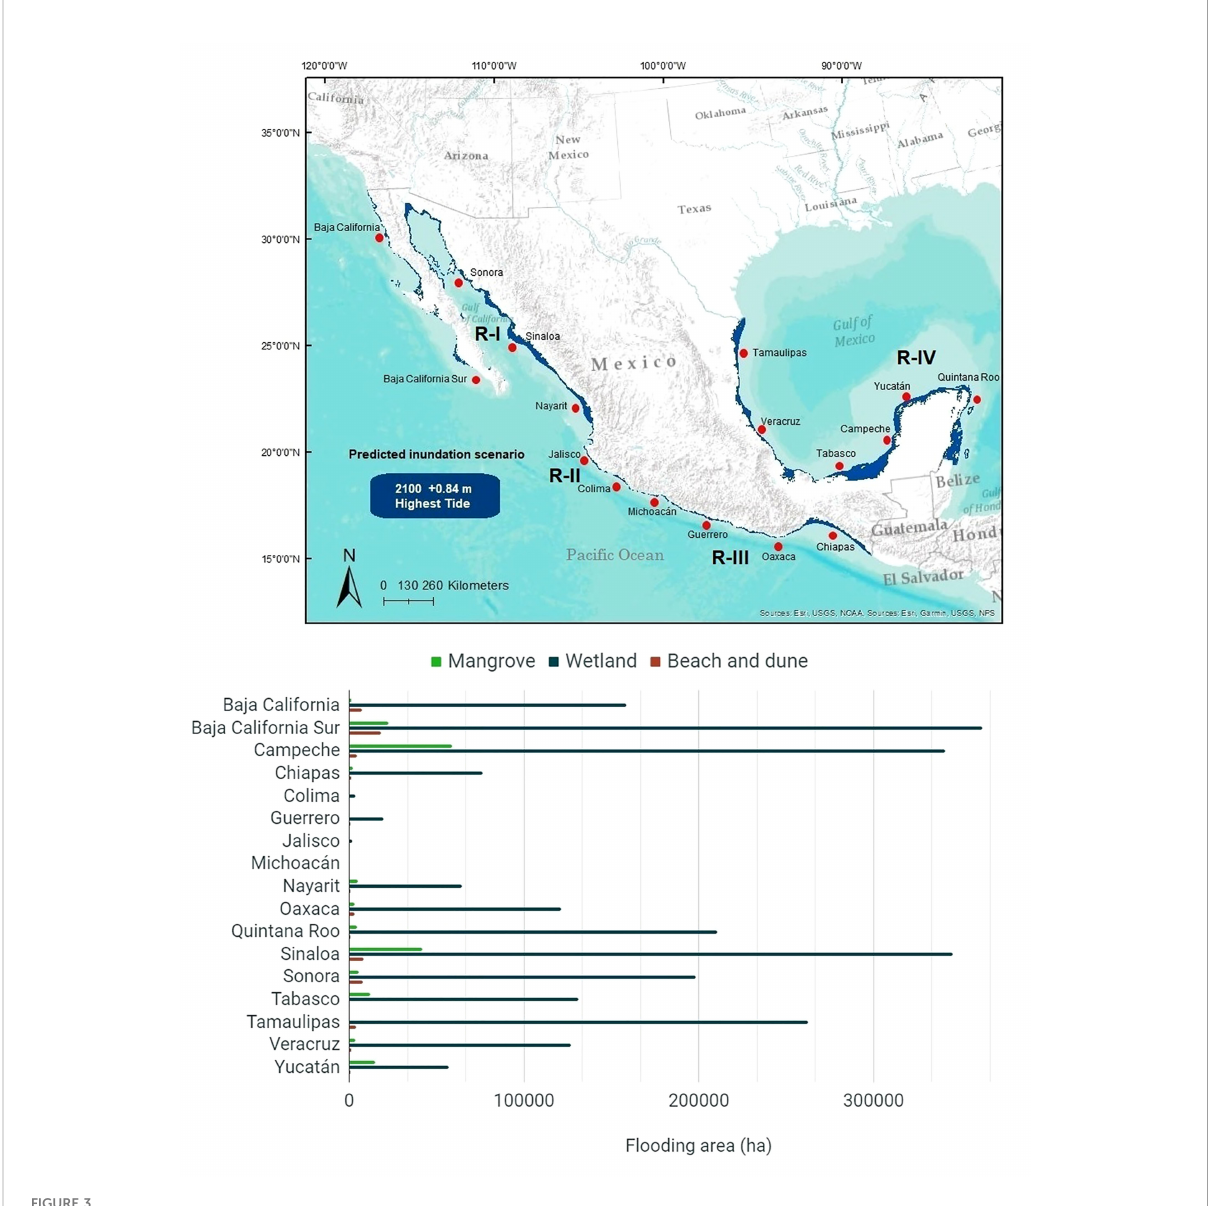
FIGURE 3 Predicted coastal fl ooding areas resulting from sea level rise in